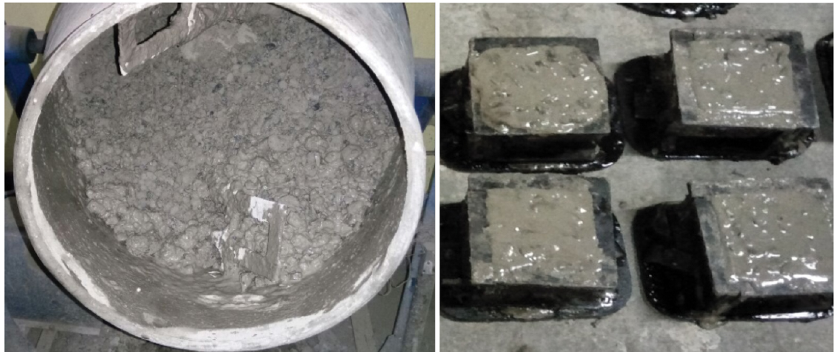
Figure 2: Geopolymer concrete at the time of mixing and